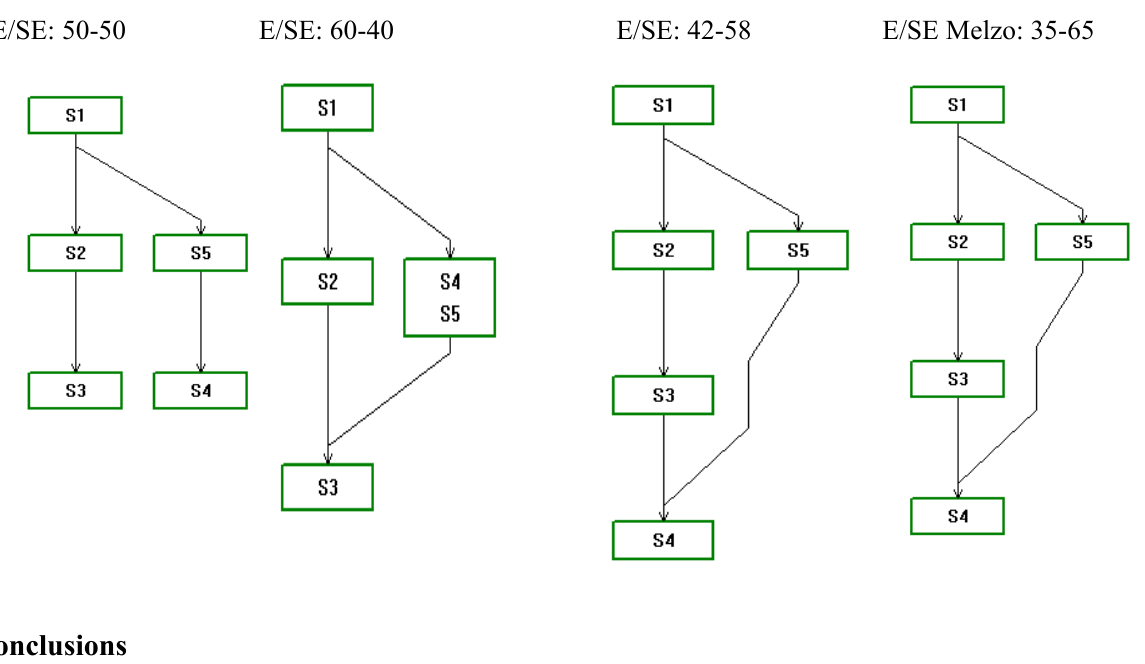
Figure 4. Results in relation to three technical weighting scenarios [Environmental (E) and Socio-Economical (SE) dimensions] and the fourth scenario from the municipality of Melzo in